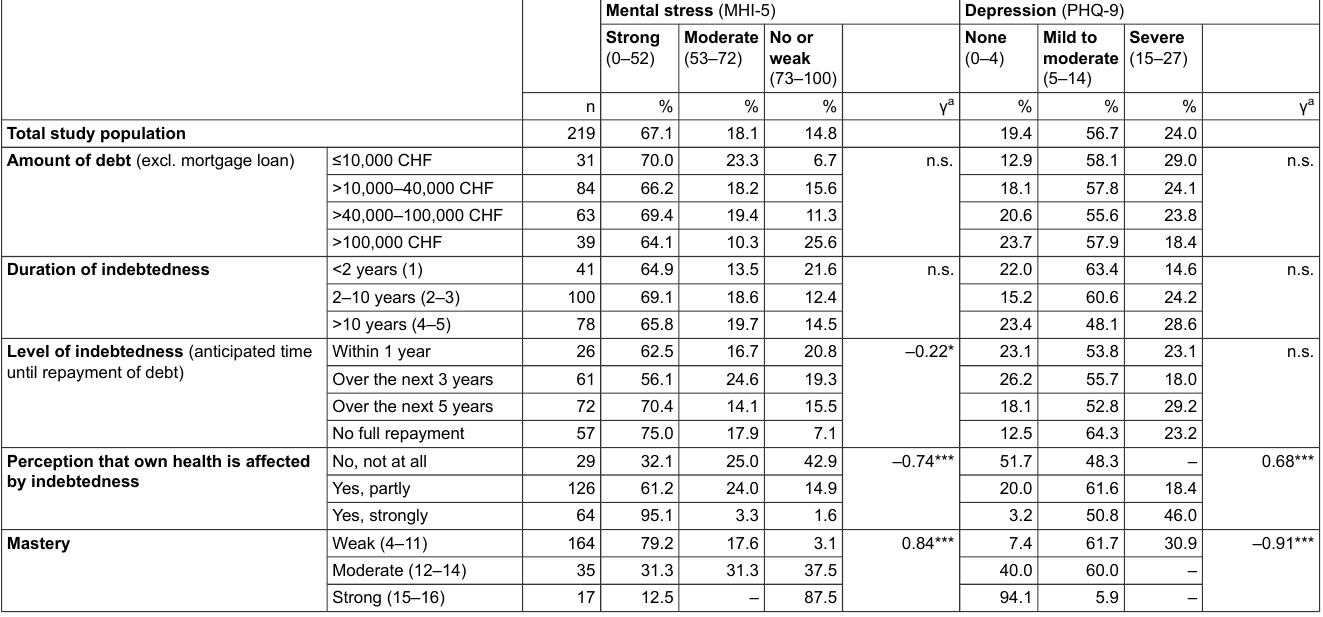
Table 3: Crosstabulations and bivariate associations of debt and personal characteristics with health outcomes in the study population of over-indebted individuals (n =